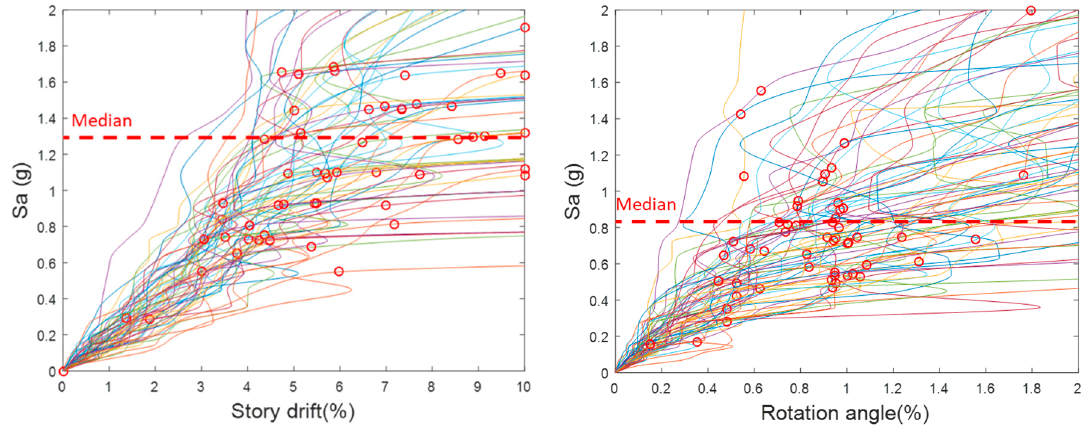
Table 9. Engineering demand parameters for seismic fragility assessment.